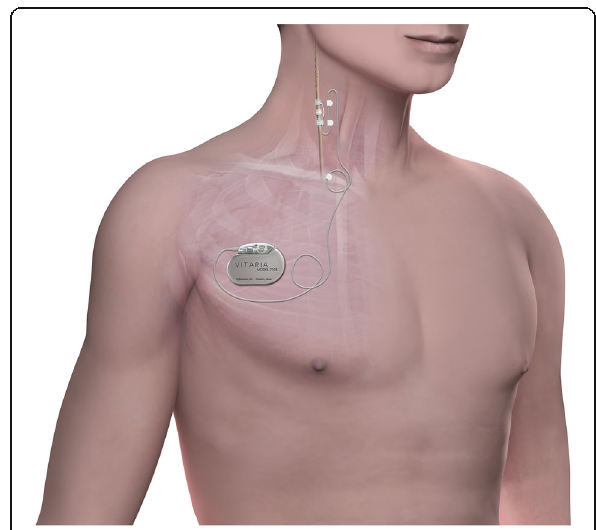
Fig. 1 The VITARIA Autonomic Regulation Therapy (ART) system implanted on the right cervical vagus nerve, which consists of a Pulse Generator and lead